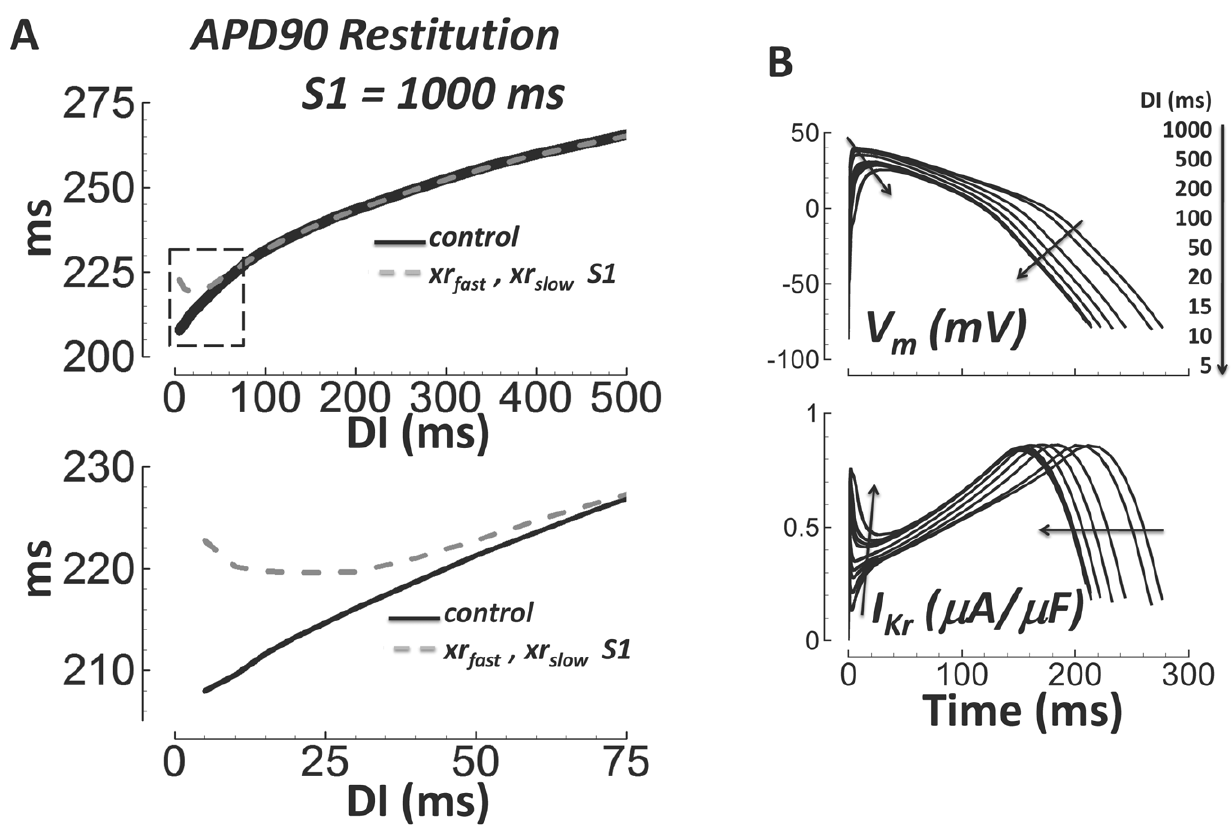
Figure 17. I Kr deactivation is important for APD restitution at very short DIs. A) APD restitution in control (solid black), and when the fast and slow deactivation gates (xr fast and xr slow ) were reset to the DI=S1=1000 ms value at the start of the S2 beat (dashed gray). Bottom) Zoom in to more clearly show the consequence of deactivation resetting at short DIs (section outlined by dashed box above). B) Traces for the AP (top) and I Kr (bottom) during the S2 beat at different DIs (indicated by arrows). Spiking in I Kr occurred early during the AP at short DI. Spiking was caused by slow deactivation, increasing availability of I Kr .